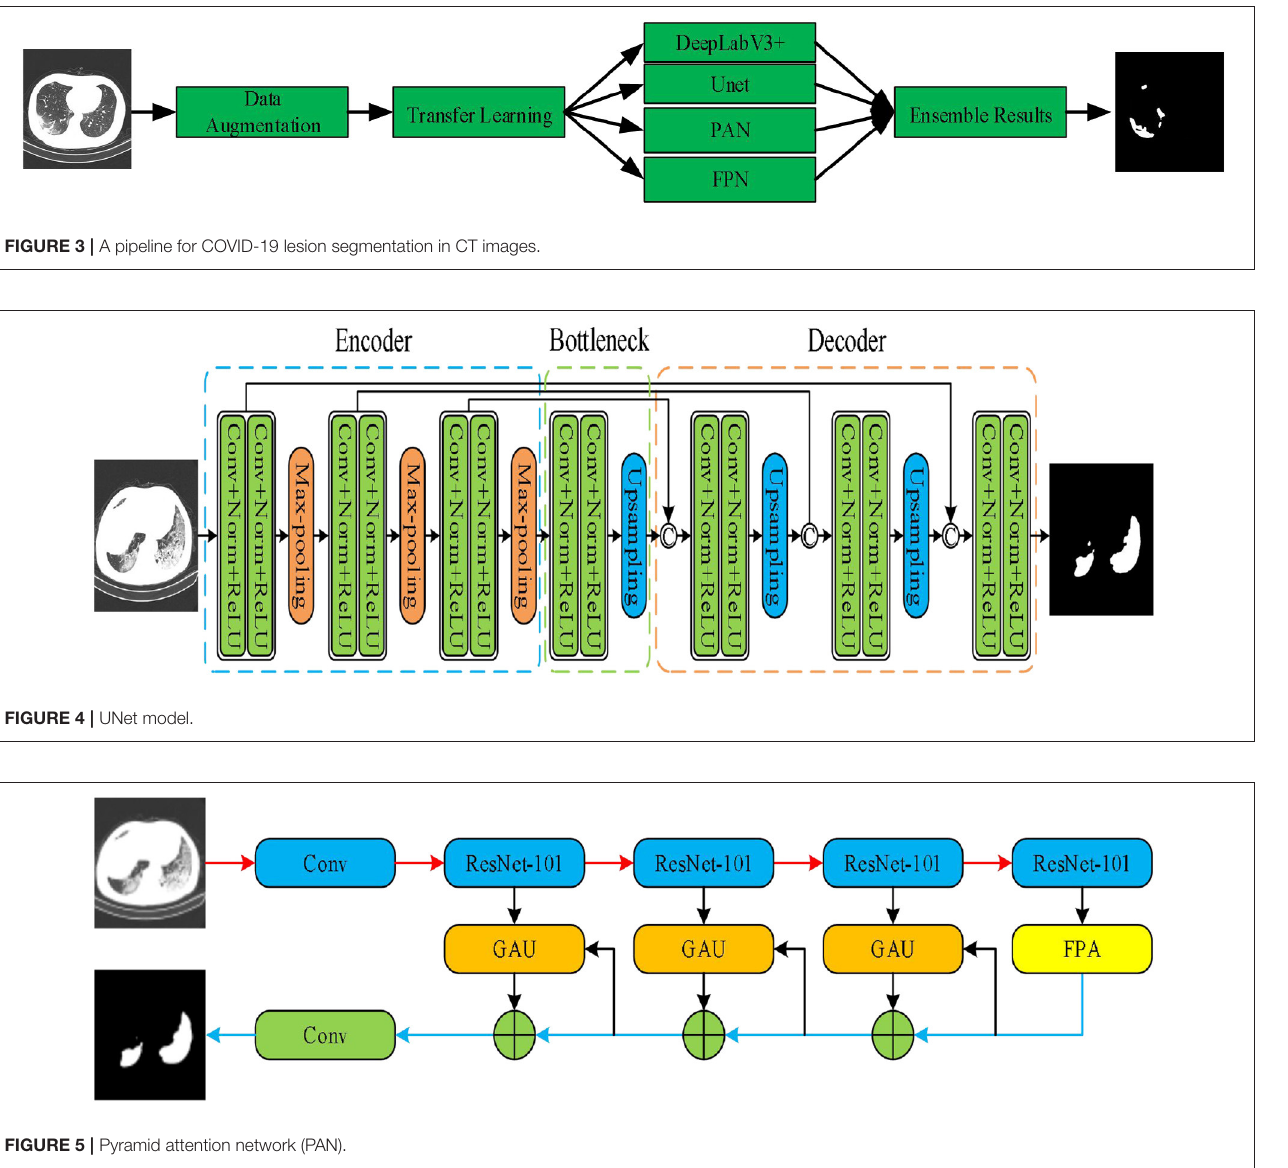
FIGURE 5 | Pyramid attention network